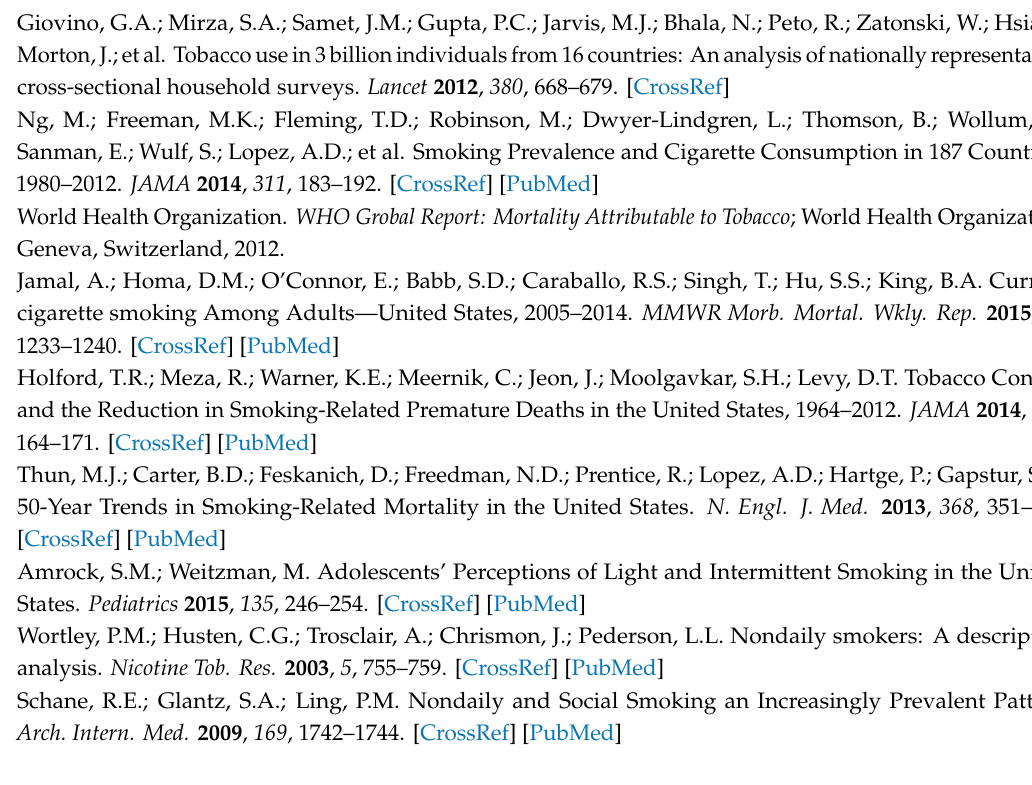
Figure S1: Dose-response associations of cigarette smoking with (A) all-cause, (B) cancer-specific mortality, (C) CVD-specific mortality, and (D) respiratory disease-specific mortality in U.S. adults; Table S1: Meta-analyses of cigarette smoking status with risk of all-cause mortality according to baseline survey year; Table S2: Cigarette smoking status and risk of all-cause and cause-specific mortality (Exclusion of participants who died within the first 2 years of follow up);Table S3: Cigarette smoking status and risk of all-cause and cause-specific mortality (Exclusion of participants who had history of physician-diagnosed diseases); Table S4: Cigarette smoking status and risk of all-cause and cause-specific mortality (using imputed data); Table S5: Cigarette smoking status and risk of all-cause mortality by sex, age group and race /